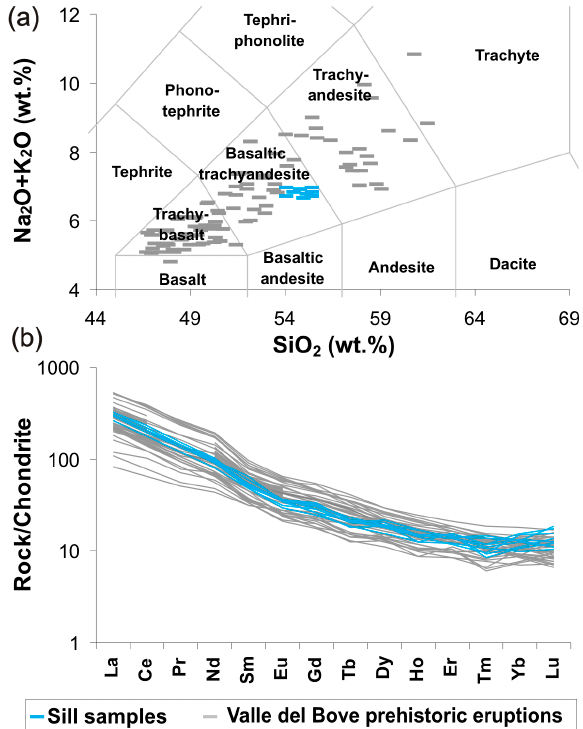
Figure 5. TAS (total alkali vs. silica; [57] diagram ( a ) and chondrite-normalized patterns [44] of REE ( b ) showing the sill bulk rock compositions.